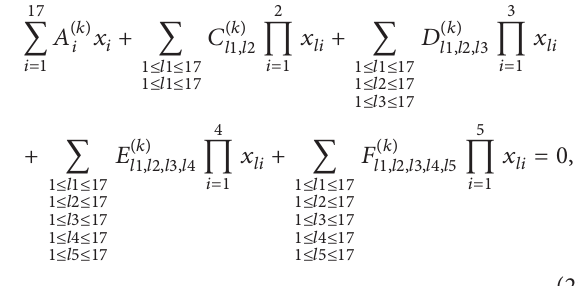
Figure 6: The stability of 22 limit cycles of system ((10a) and (10b)) with parameter conditions UP and PG is